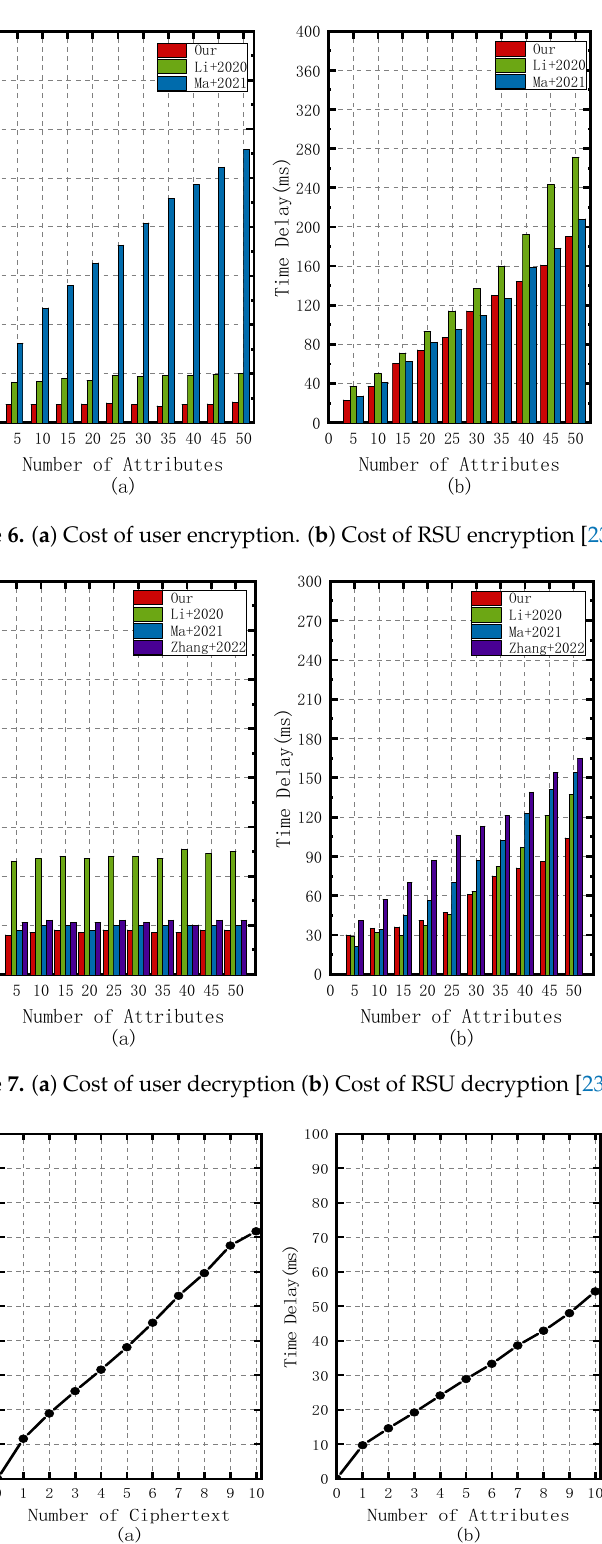
Figure 8. ( a ) Cost of single attribute revocation ( b ) Cost of multi-attribute revocation.